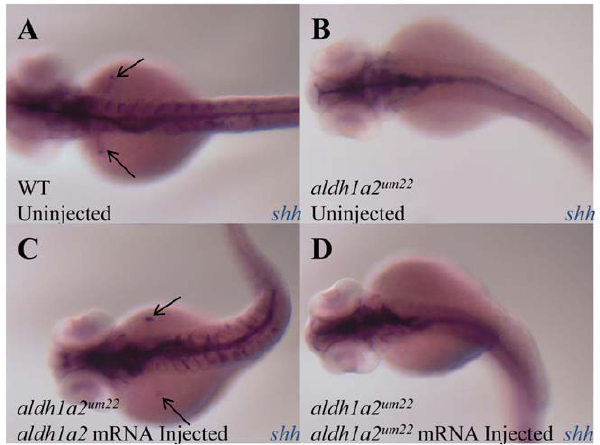
Figure 2. Wild type aldh1a2 mRNA rescues 88.21 fin bud development. Dorsal views of 48 hpf embryos with sonic hedgehog ( shh ) expression in purple. A. Uninjected wild type embryo with shh expression in the CNS and fin buds (black arrows). B. aldh1a2 um22 mutant embryos lack shh expression in the fin buds. C. aldh1a2 um22 mutant embryo injected with aldh1a2 wild type mRNA shows rescued fin bud expression (black arrows). D. aldh1a2 um22 mutant embryo injected with aldh1a2 um22 mutant mRNA is not rescued.